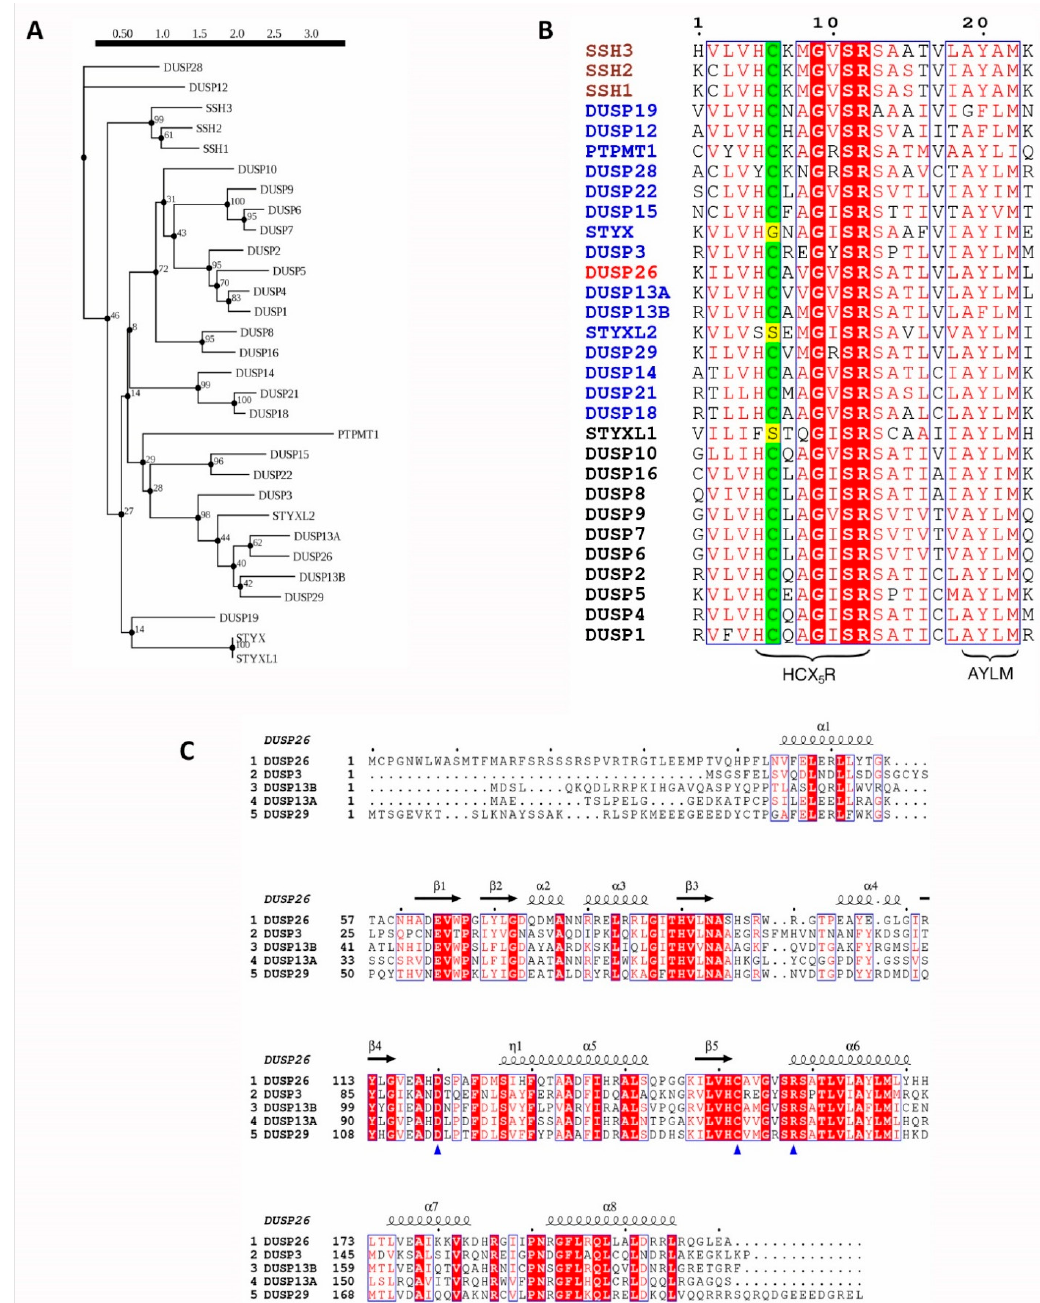
Figure 1. Evolutionary analysis of human DUSP26 and its homologous proteins. ( A ) Phylogenetic tree of human DUSP26 and its 29 closest homologous proteins. Sequences were identified using the blastp program in the UniProtKB/Swiss-Prot database. Following this, sequences were mapped onto a phylogenetic tree using the Smart Model Selection in PhyML with 100 bootstrap replications applied [37,38]. ( B ) Protein sequence alignment of the active site region of DUSP26 and 29 closest homologous protein sequences. Catalytic cysteine highlighted in green; pseudo-catalytic residue of pseudophosphatases in yellow; MKP, aDUSP and SSH names are in black, blue and brown, respectively, and the DUSP26 name is in red. ( C ) Protein sequence alignment of DUSP26 and its closest homologues, excluding the pseudo-phosphatase STYXL2. Blue triangles pinpoint the catalytic triad and depicted above are the α -helices and β -sheet positions and of the DUSP26 structure. For sequence alignments, identical residues are displayed in white inside red boxes; residues with 70% similarity based on physico-chemical properties are displayed in red inside blue boxes; alignment generated using the ESPript 3.0 tool